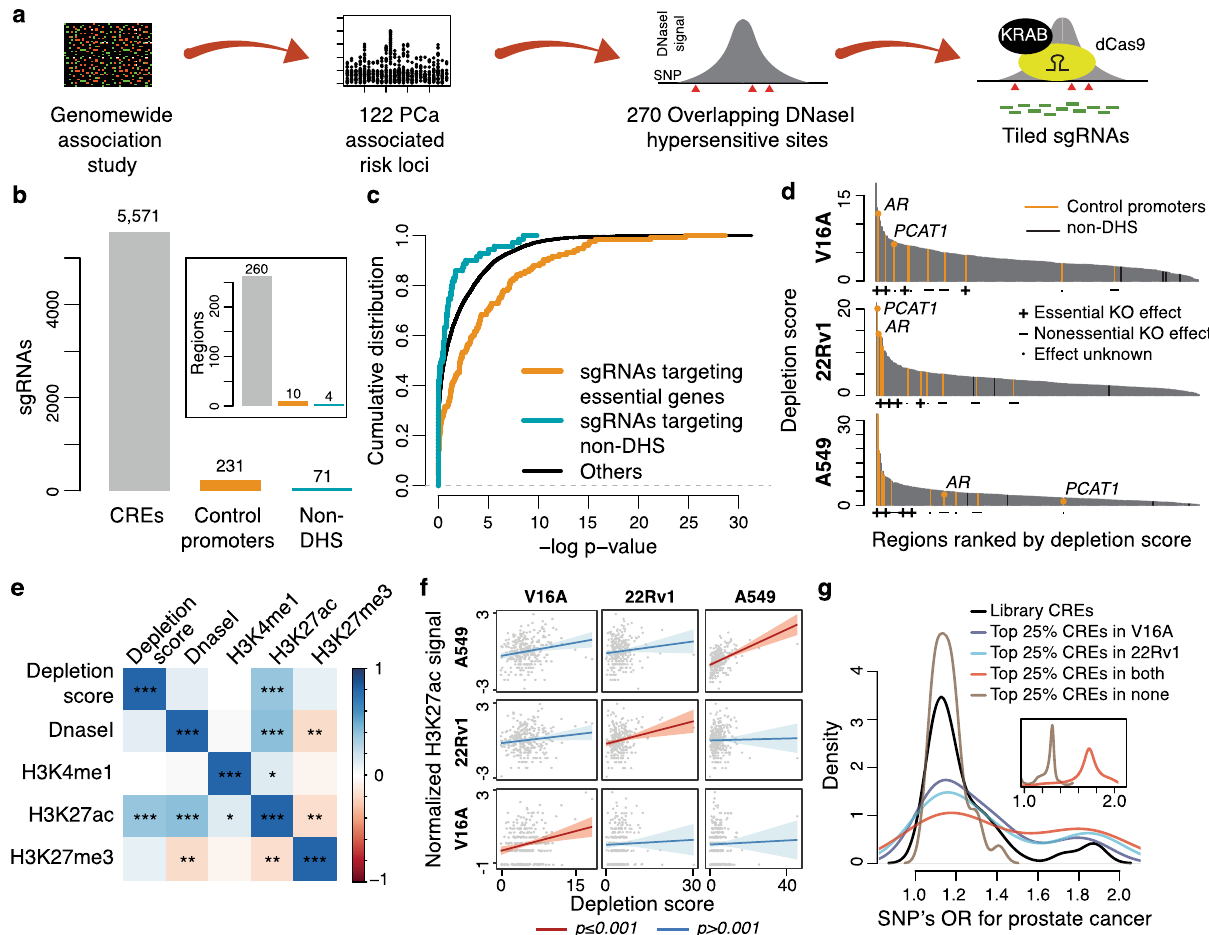
Fig. 1 CRISPRi screening of prostate cancer risk CREs. a Schematic of rCRE selection and sgRNA design. b Distribution of sgRNAs targeting rCREs or control regions. The barplot in the inset indicates the number of regions in the library. c The cumulative distribution of depletion p-values of sgRNA targeting control promoter regions that are essential for growth in Achilles DepMap project (orange), sgRNAs targeting non-DNaseI hypersensitive sites (green), and sgRNAs targeting rCREs (black). Depletion p values were estimated using the tool MAGeCK (see ‘ Methods ’ ). d rCREs ranked by their depletion scores in three cell lines. Promoters of two prostate-speci fi c oncogenes, AR and PCAT1 , are labeled. The panels below the plots indicate the knockout effects of the control genes on respective cell growth as observed in Achilles DepMap project. e Correlation of LNCaP ChIP-seq signals of several histone marks with the depletion score in LNCaP-derived V16A cells. P values are estimated using Spearman ’ s correlation test. The colors of the box correspond to the correlation coef fi cient and the * corresponds to the statistical signi fi cance of correlation test. *, p ≤ 0.05; **, p ≤ 0.01; ***, p ≤ 0.005. f Linear regression between H3K27ac ChIP-seq signals and CRISPRi depletion score in cell line-speci fi c manner. The solid lines denote the best fi t for the regression model and the shaded areas denote 95% con fi dence interval. P value is calculated using linear regression analysis. g Distribution of odds ratio for PCa conferred by the risk SNPs within library rCREs. The black line denotes OR of risk SNPs in rCREs in the library; the colored lines denote top 25% rCREs when ranked by their depletion scores in PCa cell lines. The inset plot demonstrates the OR distribution by risk SNPs in bottom 75% rCREs (brown) and top 25% rCREs in both V16A and 22Rv1 cells (red) normalized by the overall OR distribution of all library risk SNPs. The inset axes are the same as the main plot